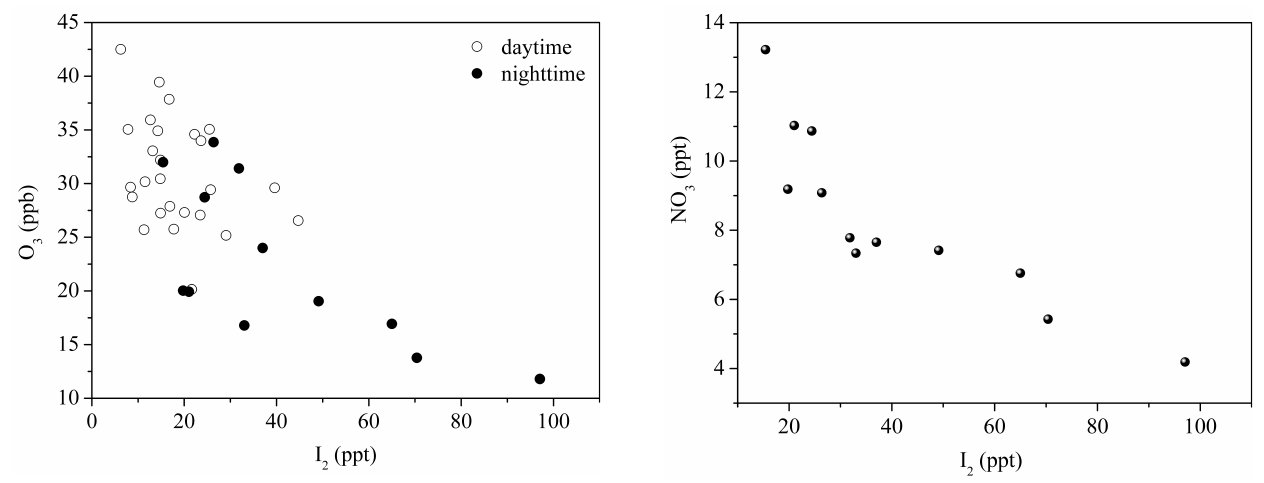
Fig. 7. NO 3 as a function of I 2 at night at Mweenish